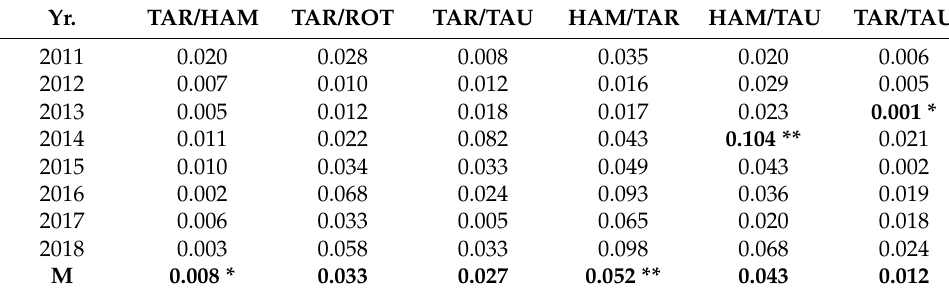
Table 3. Niche overlap by event